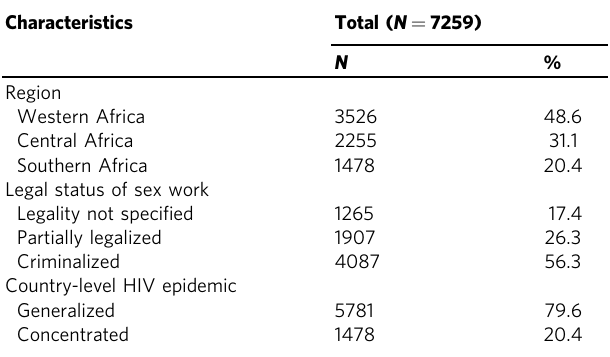
Table 2 Study sample by region, legal status of sex work, and country-level HIV